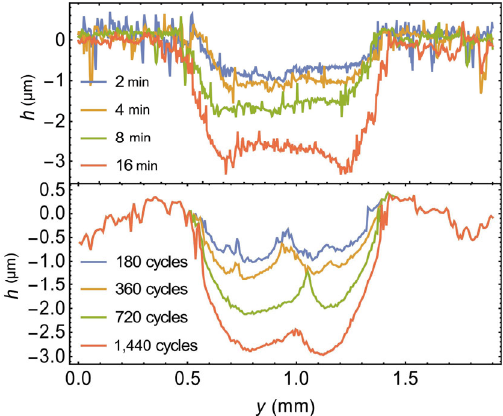
Fig. 6 Center profiles of the experiment and Arrhenius- based model.